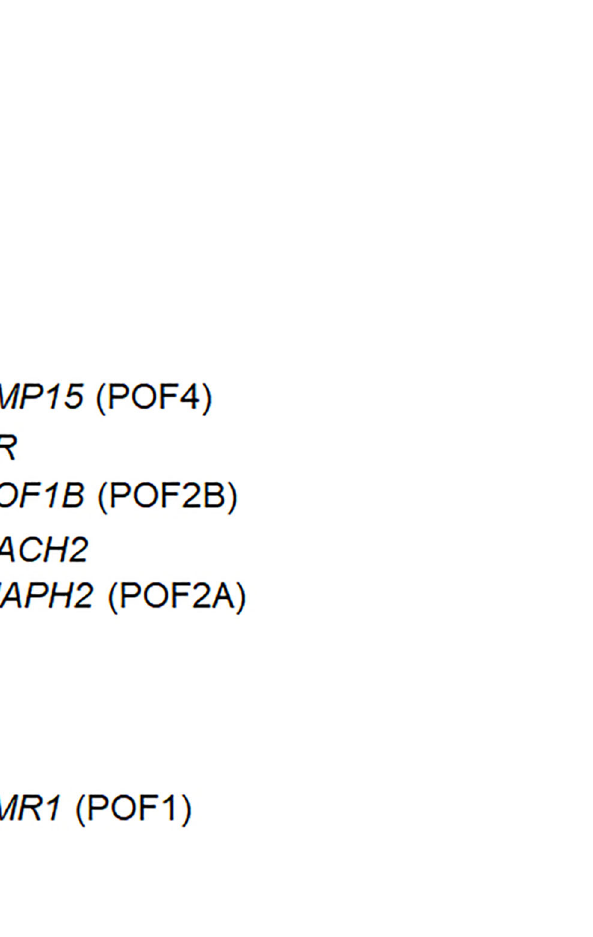
FIGURE 1 X chromosomal genes possibly associated with ovarian function. At least six genes have been implicated in ovarian development or function. Of these, BMP15 , POF1B , DIAPH2 , and FMR1 have been designated as premature ovarian failure (POF)